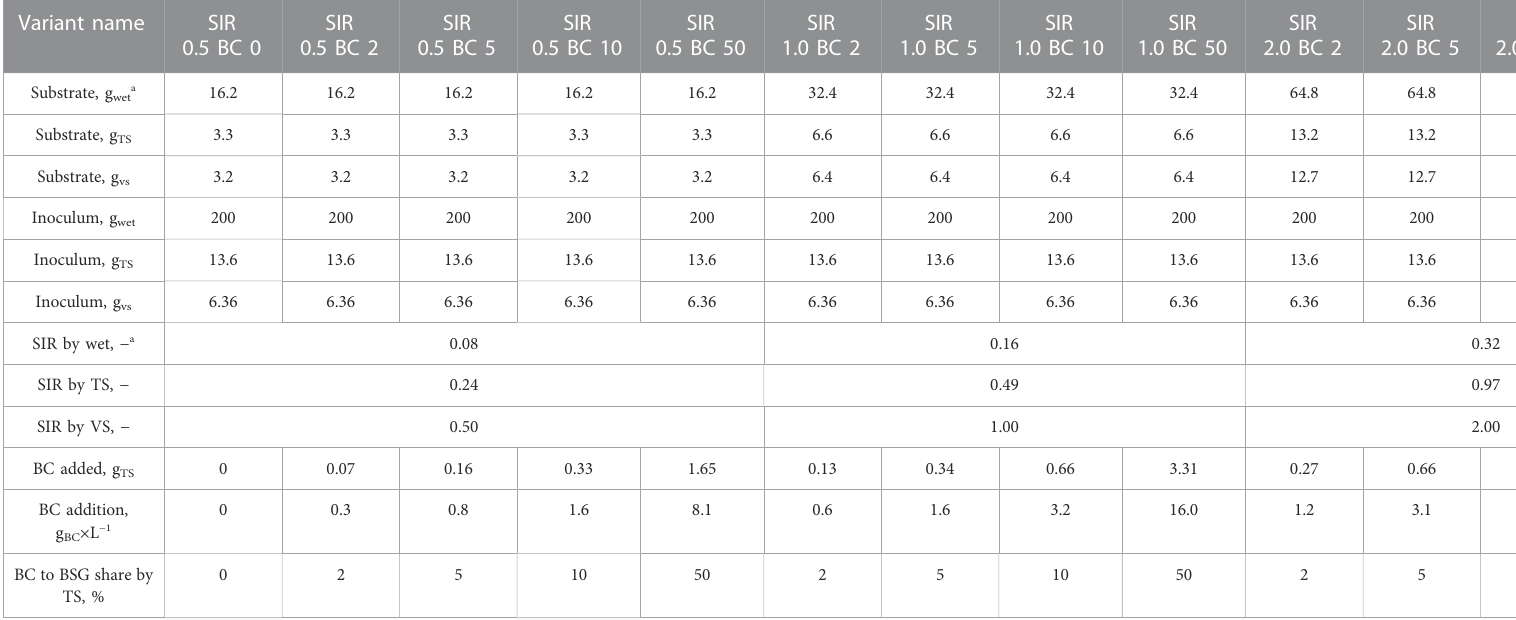
TABLE 1 Anaerobic digestion experiment matrix and reactors